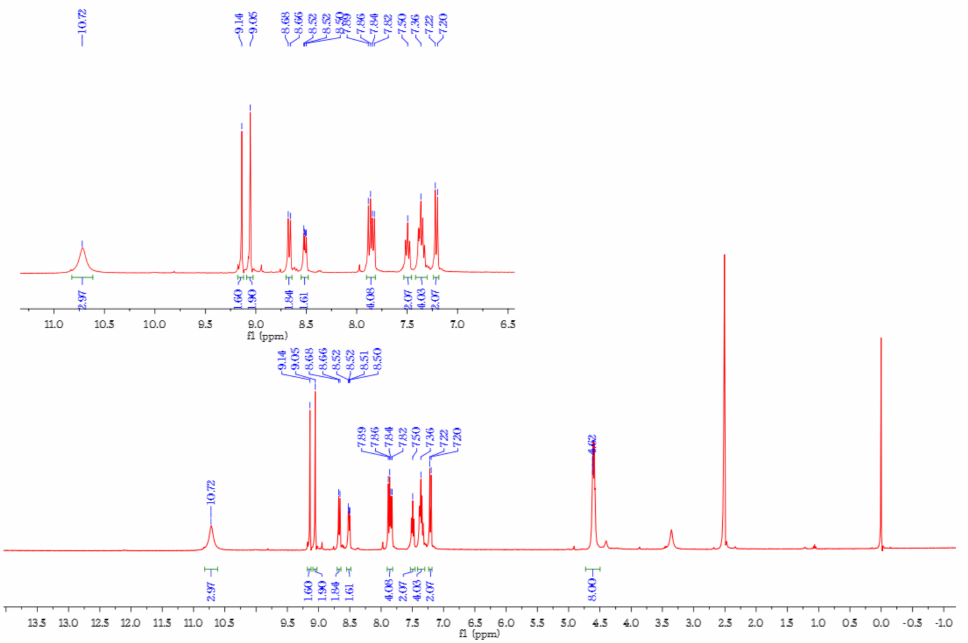
Figure 1. 1 HNMR spectra of sensor H 4 L in DMSO.